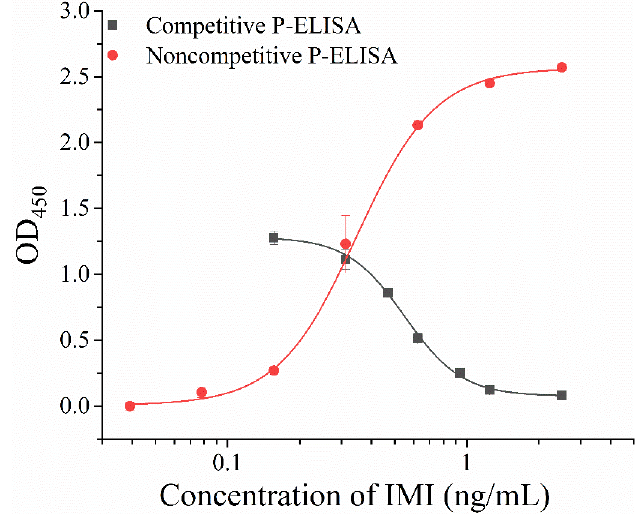
Figure 3. Standard curve of P-ELISAs.